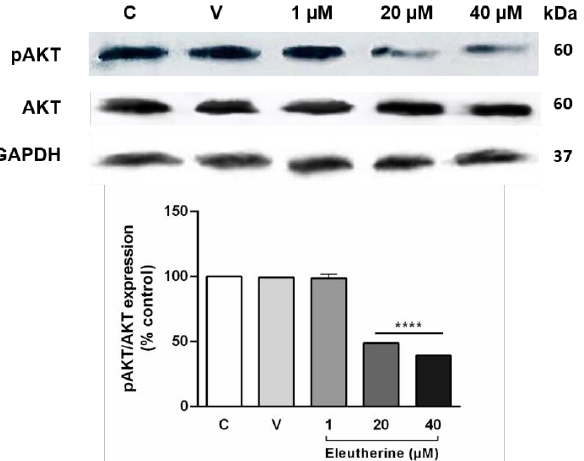
Figure 7. Eleutherine treatment reduced AKT phosphorylation in C6 cells. The expression of pAKT and AKT, and of GAPDH as the control protein, was detected by western blotting. The pAKT:AKT ratio is expressed as a percentage. The eleutherine treatment groups (20 and 40 µM) showed a greater reduction in AKT phosphorylation than was observed in the untreated group. Data are presented as the mean ± SEM of three independent trials. Here, **** p < 0.0001 vs. untreated control (ANOVA, Tukey’s post hoc test); C, control; V, vehicle.